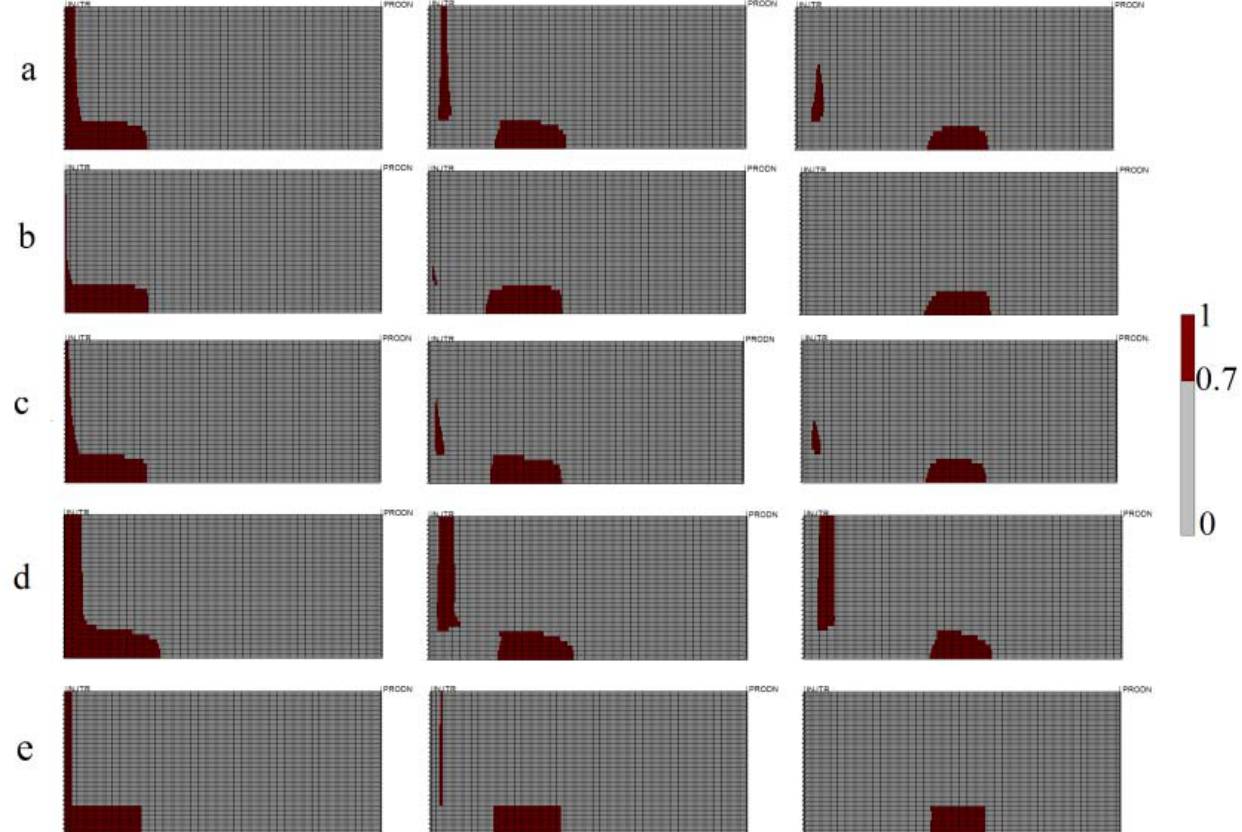
Figure 16. Snapshots of Na-silicate concentration ratio in the two-layered reservoir at three different moments: just after slug injection (to the left), at the midway to the target (middle) and at the targeted distance (to the right). The results are shown for different studied Cases ( a – e ), listed in Table